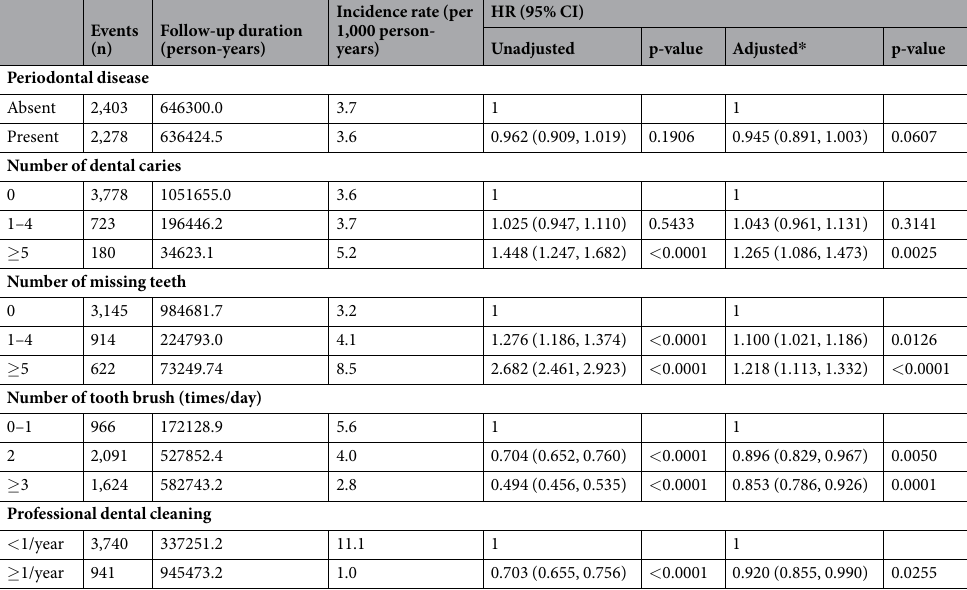
Table 2. Hazard ratio and 95% confidence interval for incidence of pneumonia (Def. 3) according to oral health status and oral hygiene behaviors (n = 122,551). Values adjusted for age, sex, body mass index,